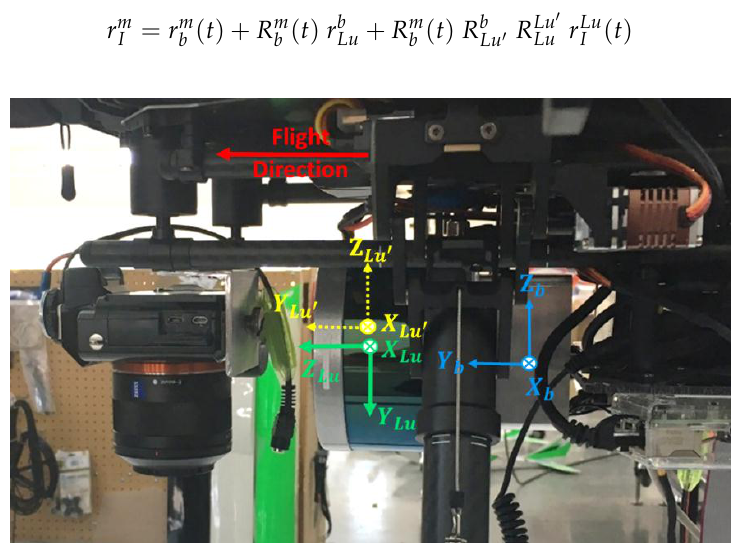
Figure 5. Coordinate Systems for UAV-based LiDAR System.